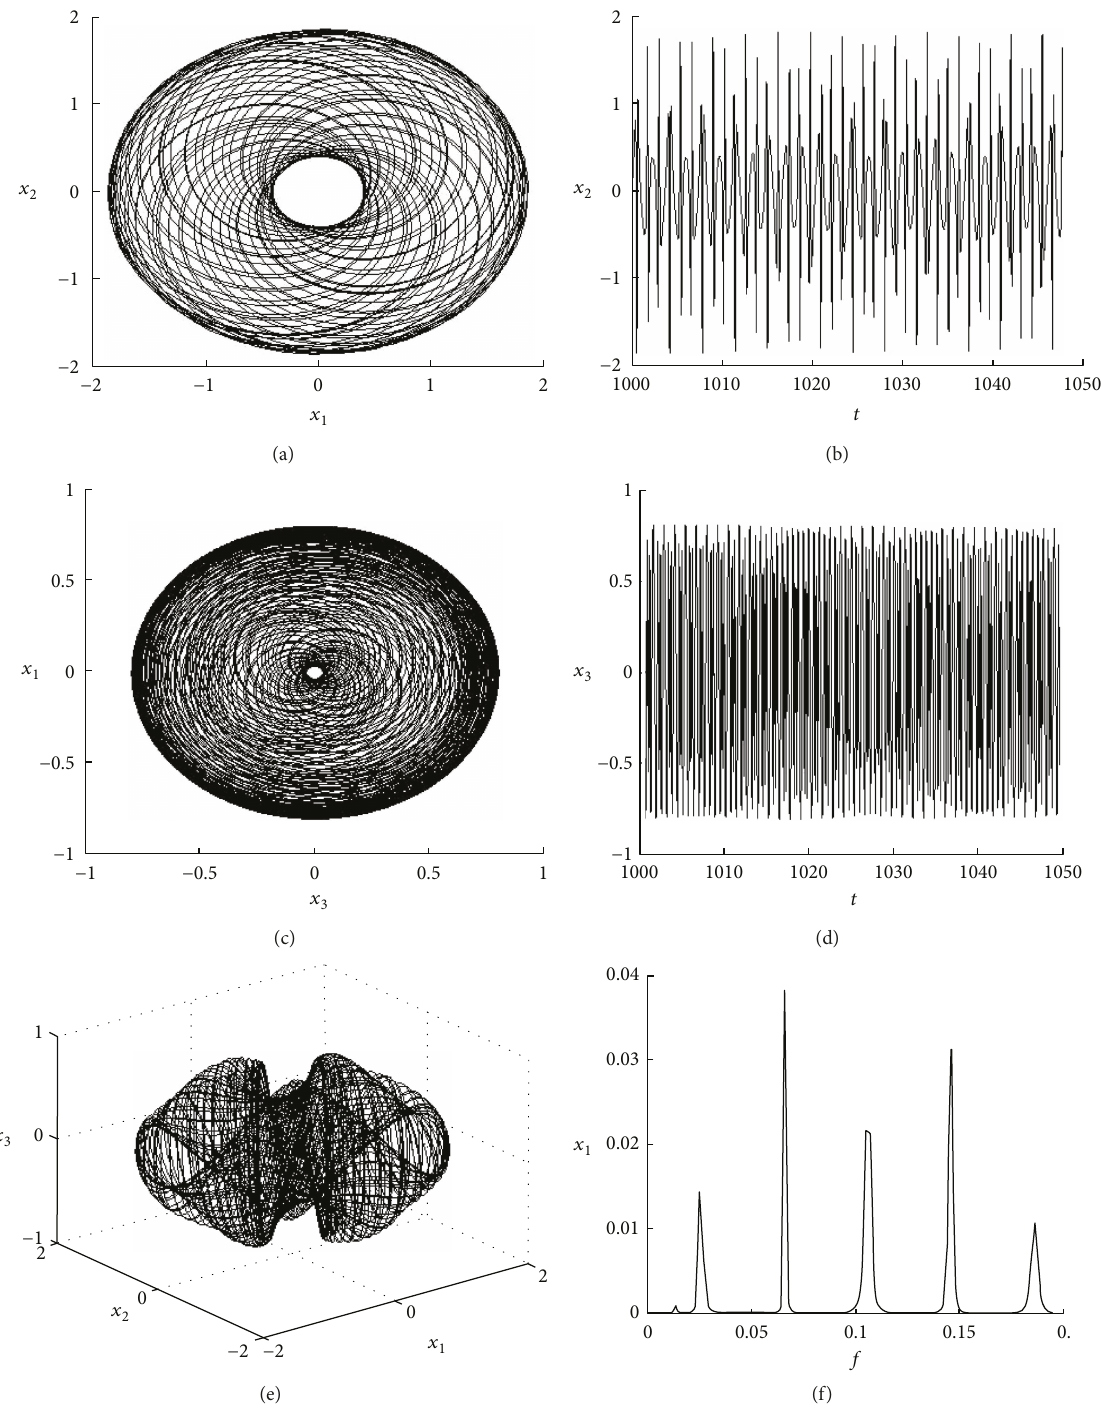
Figure 7: The multiperiodic motion of the blade with varying rotating speeds when Ω the waveform on the plane t , x the three-dimensional space x